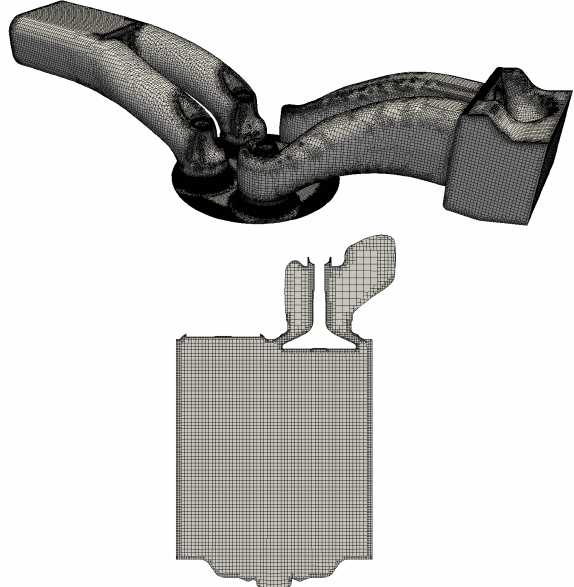
Figure 5. Example of the grid used for the cold flow simulation: full view of the mesh during the overlap phase ( top ) and cross-section of the grid during the intake phase ( bottom ).